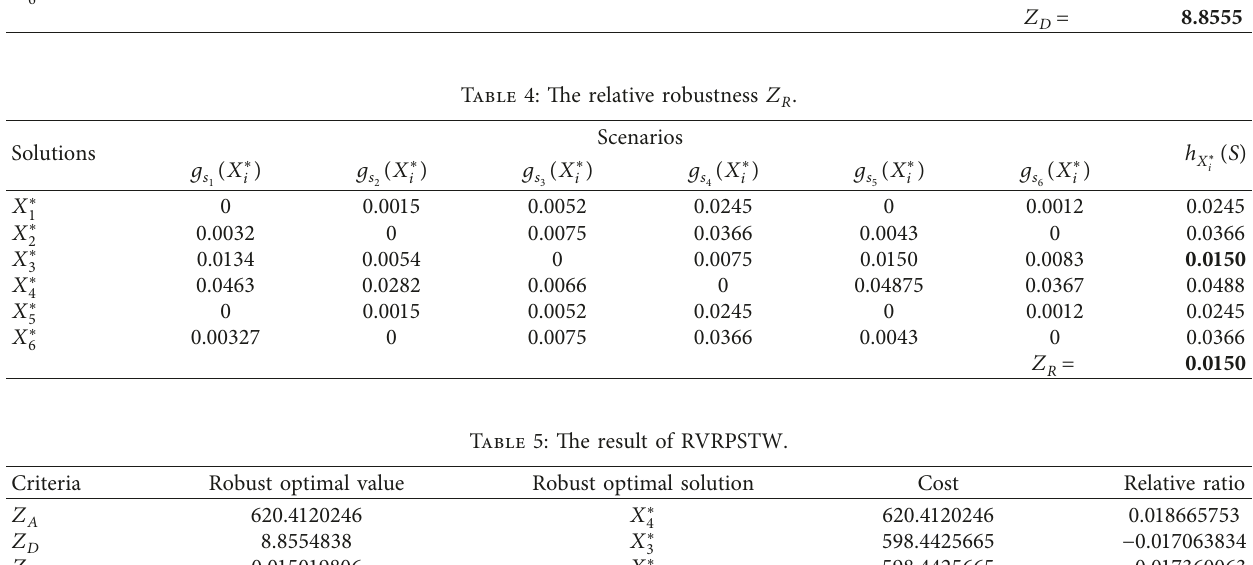
Table 4: The relative robustness Z